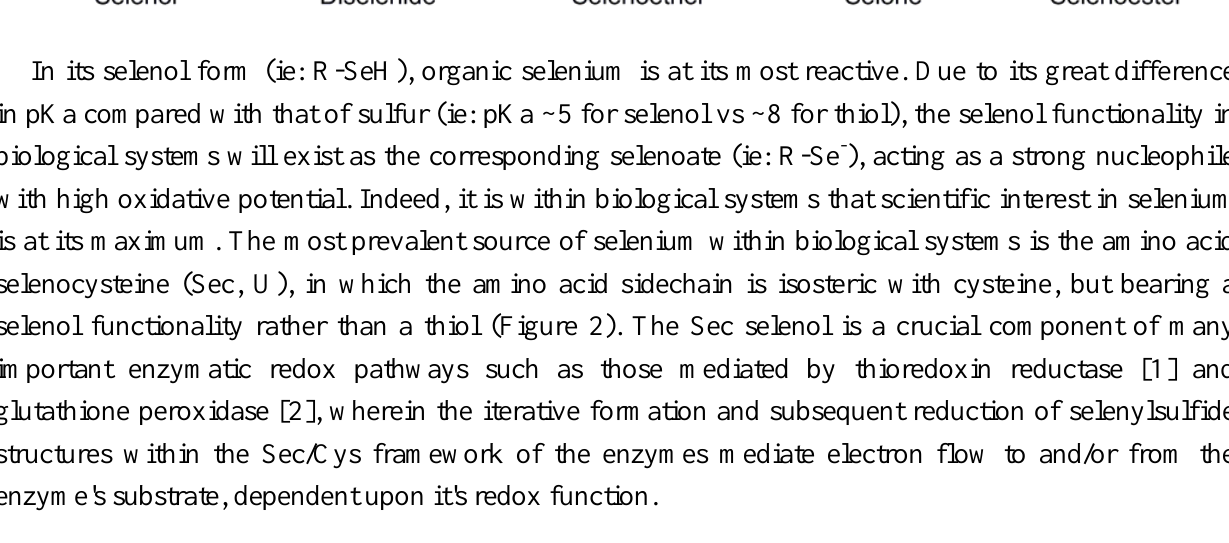
Figure 2. Structural comparison between selenocysteine and